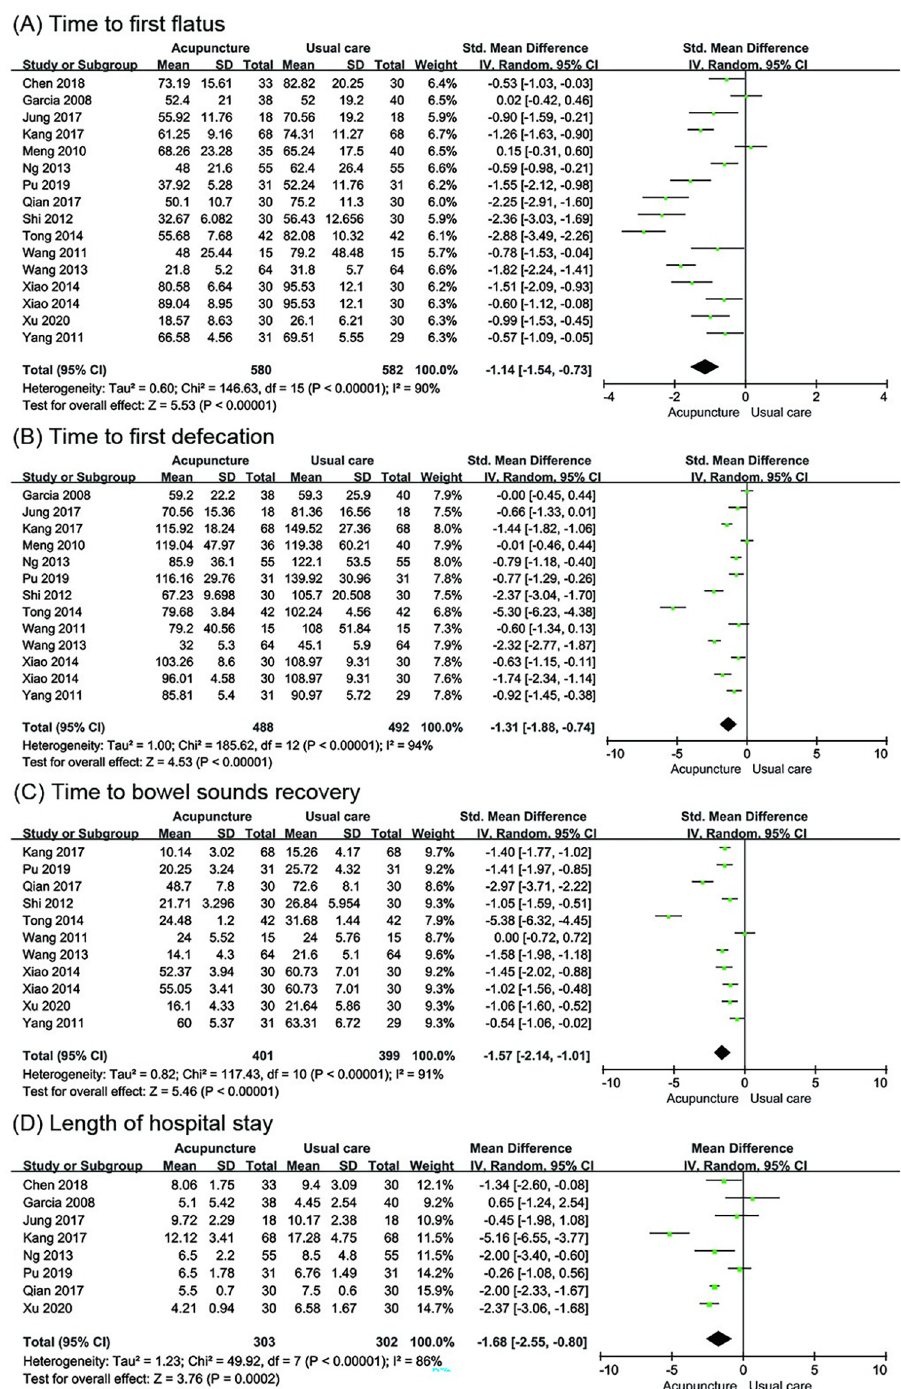
Fig 3. Meta-analysis of acupuncture versus usual care for (A) Time to first flatus, (B) Time to first defecation, (C) Time to bowel sounds recovery and (D) Length of hospital stay.